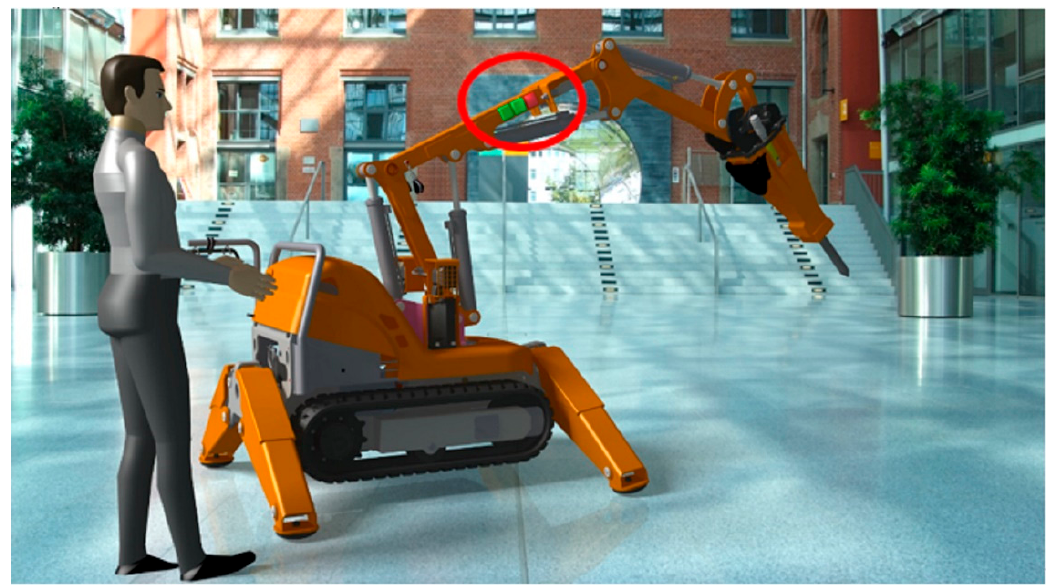
Figure 13. Robot arm equipment with an HMI lighting system (marked by a circle) showing conditions of stress and overload.